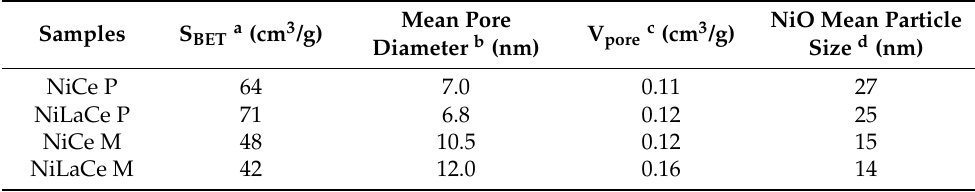
Table 1. Physico-chemical properties of the